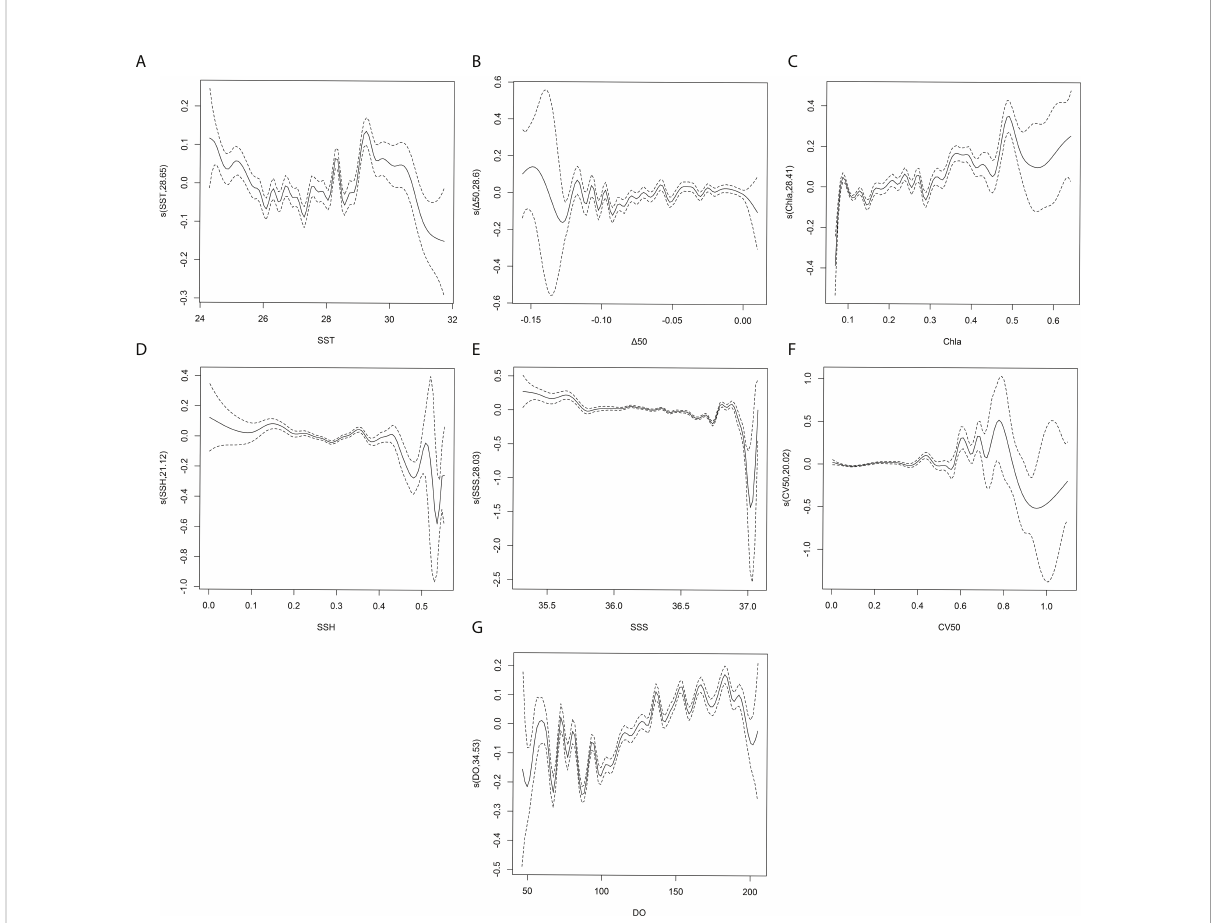
FIGURE 14 Analysis of the results of the GAM model of the in fl uence of environmental variables on CPUE. (A) SST, (B) △ 50, (C) Chla, (D) SSH, (E) SSS, (F) CV50, (G) DO, the solid line is the in fl uence curve, and the 95% con fi dence interval between the two dashed